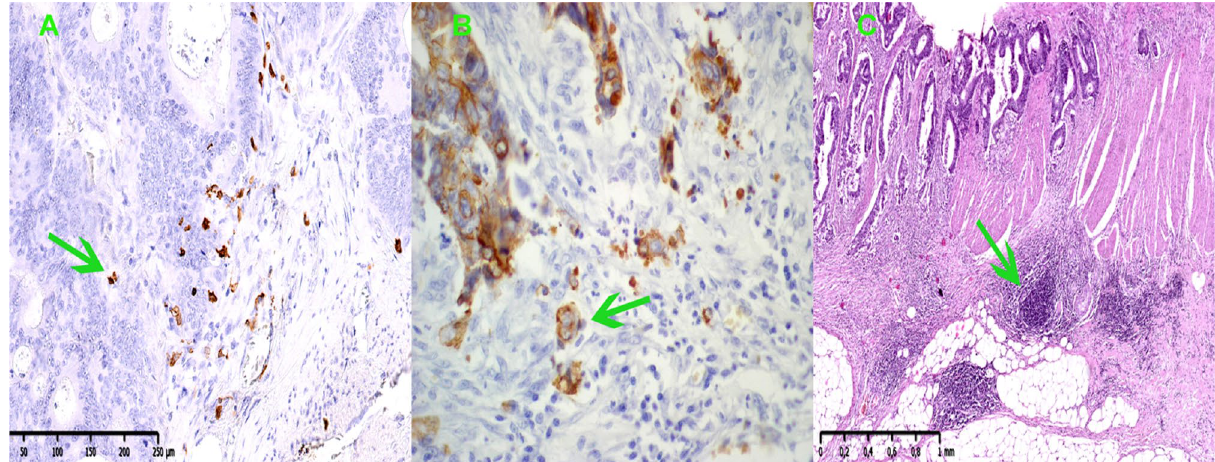
Figure 1. ( A ) Representative examples of CD8 cells expression in colorectal cancer tissue, × 100 magnification. ( B ) Representative examples of tumor budding at the front of invasion in colorectal cancer tissue, × 40 magnification. ( C ) Representative examples of lymphoid follicles in the front of tumor invasion in colorectal cancer tissue, × 40